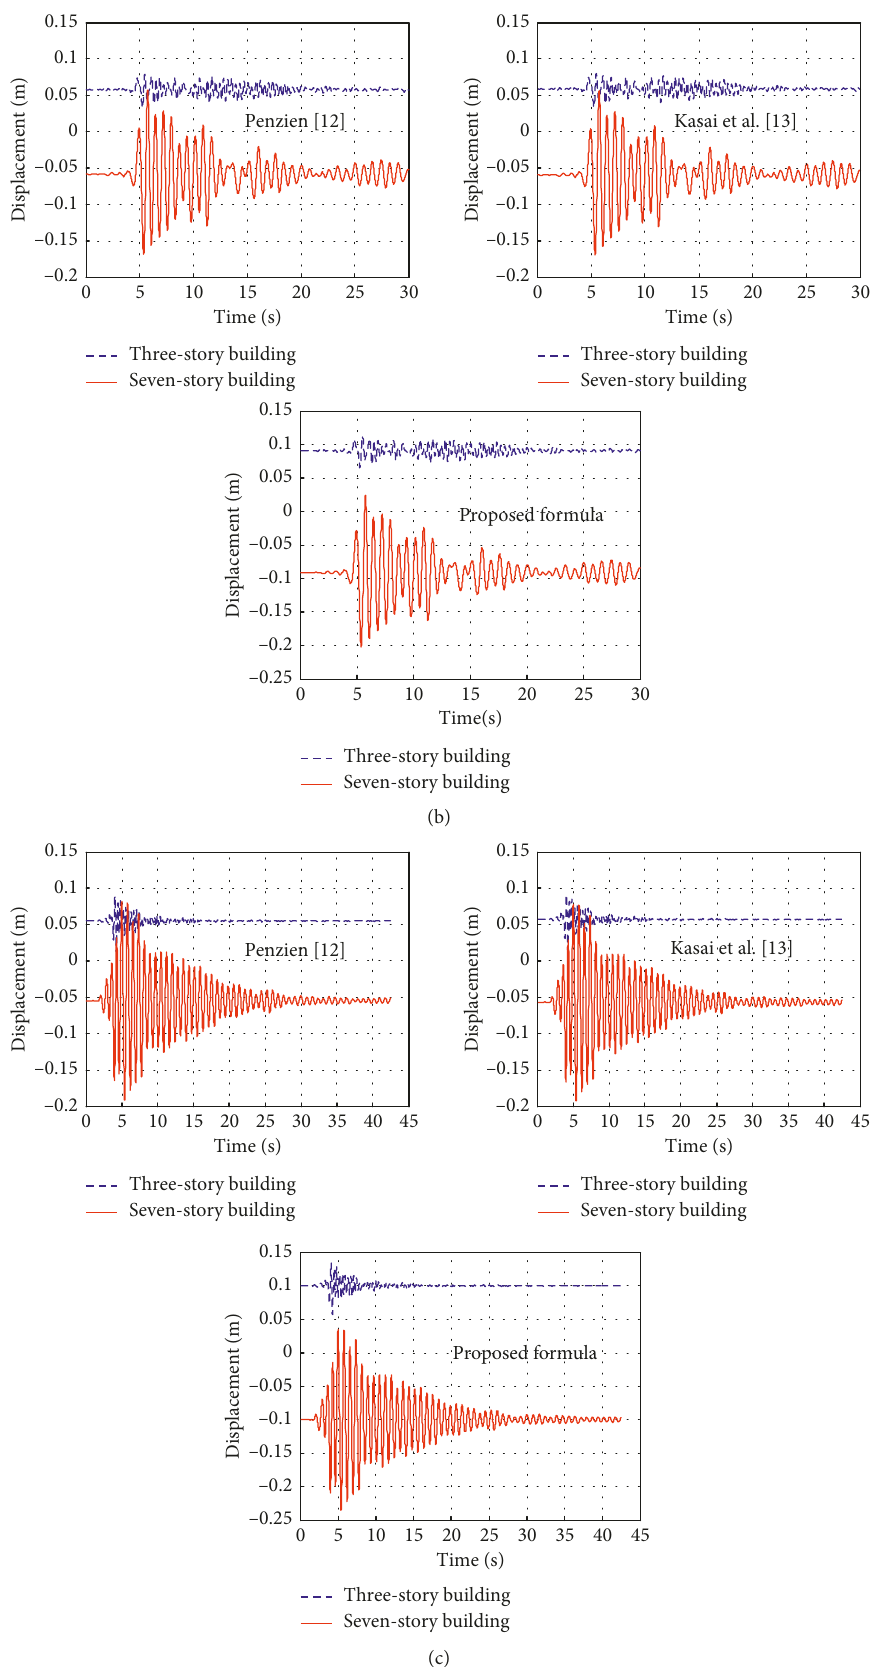
Figure 5: The lateral displacements of two buildings with gap size calculated by different methods for different earthquake records (inelastic buildings). (a) Kobe earthquake. (b) Loma Prieta earthquake. (c) Parkfield